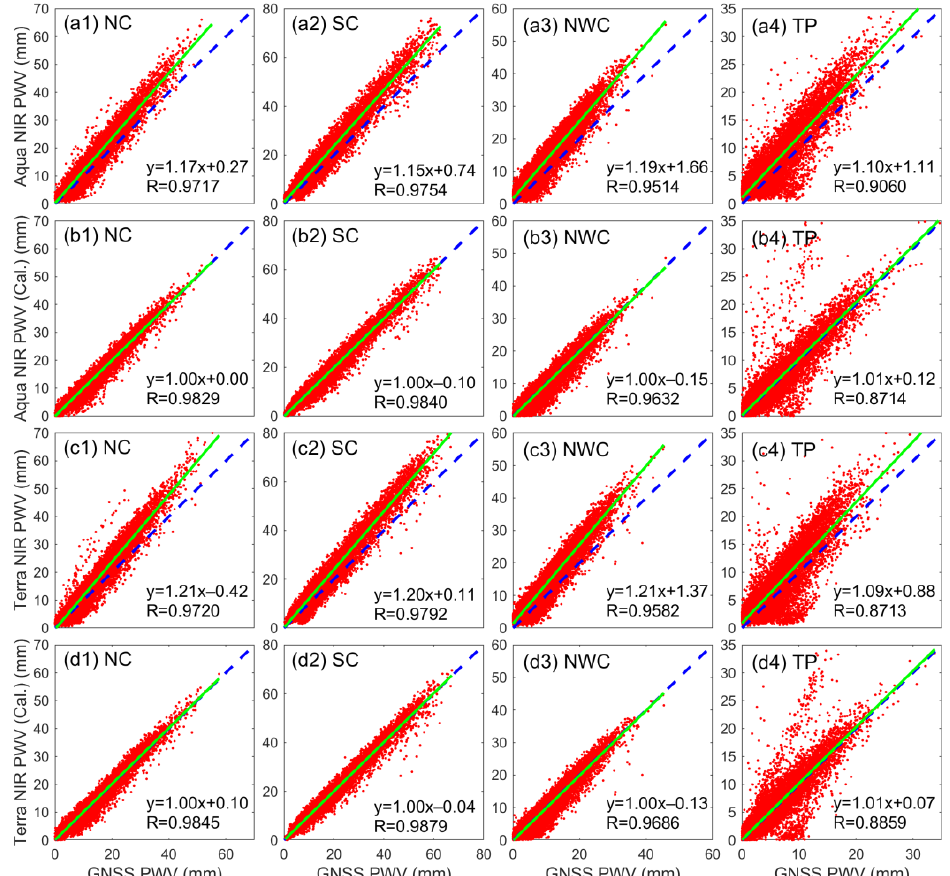
Figure 7. Scatterplots of the MODIS-derived NIR PWV values with and without calibration over the period 2011 – 2017 in the four areas in China, where ( a1 – b4 , c1 – c4 ) are the comparison of Aqua/Terra NIR and GNSS PWV, and ( b1 – b4 , d1 – d4 ) are the comparison of calibrated Aqua/Terra NIR and GNSS PWV.